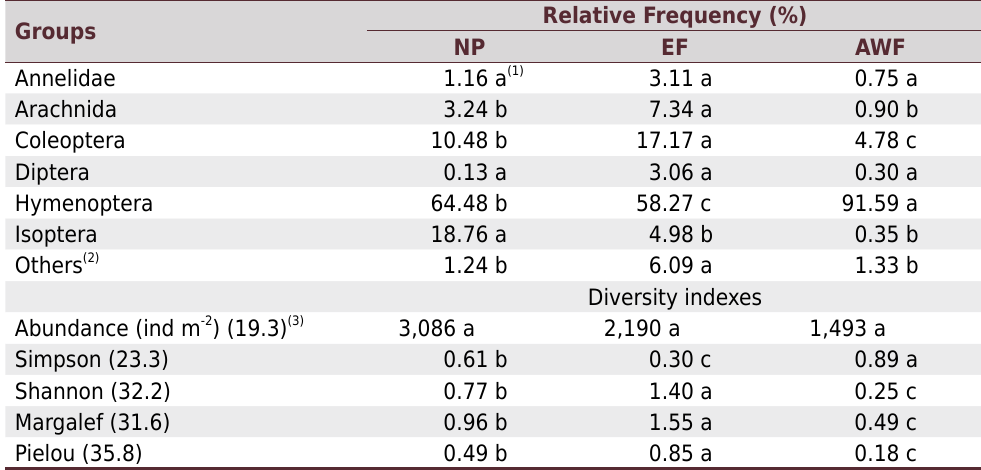
Table 2. Relative frequency of macrofauna in the soil, total abundance, and the diversity indexes of the soil under natural pasture (NP), eucalyptus forest (EF), and eucalyptus forest after wildfire (AWF), in São Gabriel, RS, Brazil